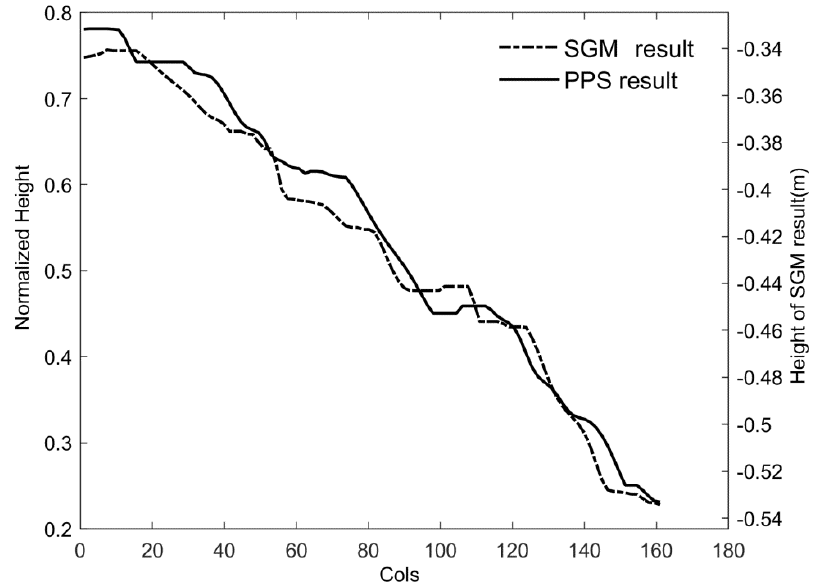
Figure 18. Height profile of ROI 2 in Yutu-2 rover imagery.